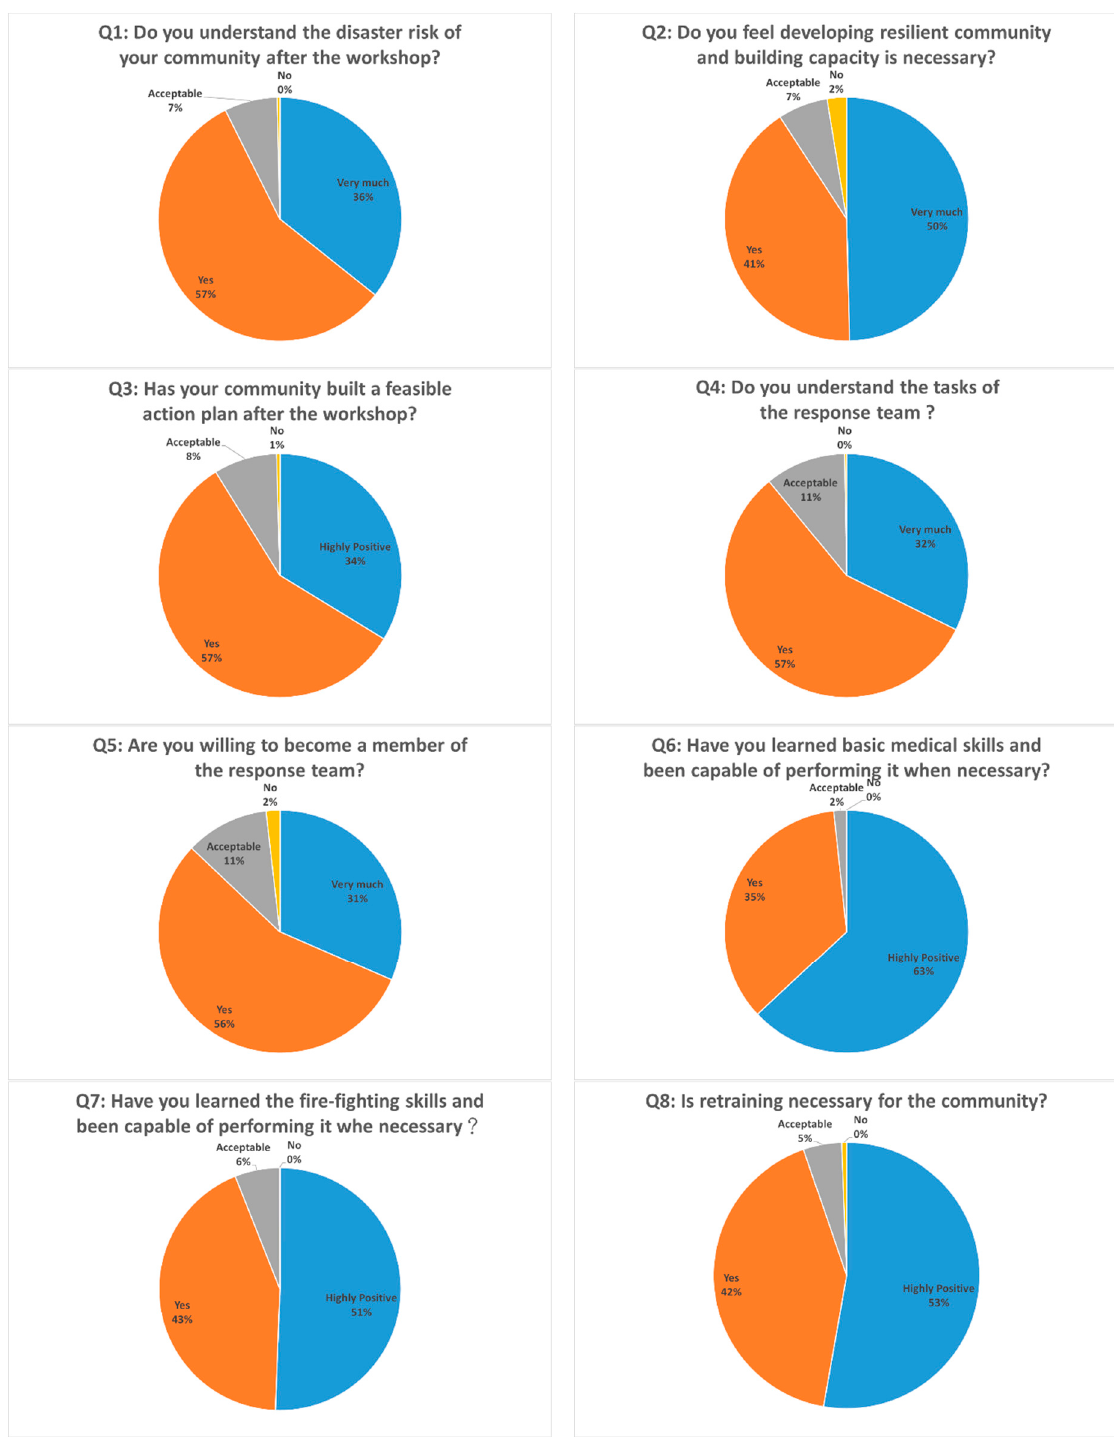
Figure 4. Results of the Questionnaire Survey.